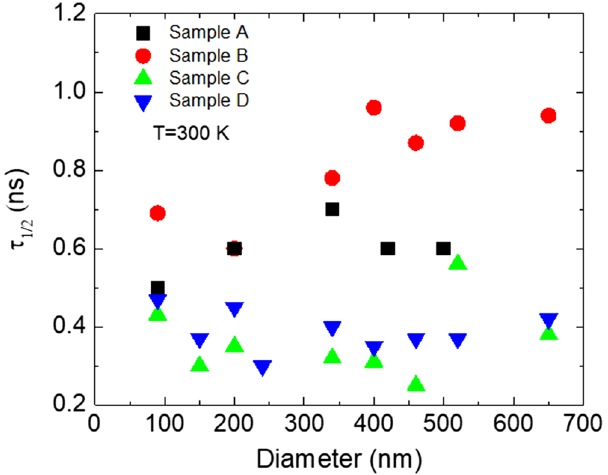
Figure 6. Half intensity decay time at room temperature of the four samples A, B, C and D of GaN NRds with threefolds InGaN/GaN axial MQWs with different In compositions and QWs thicknesses as a function of the diameter of the NRds.